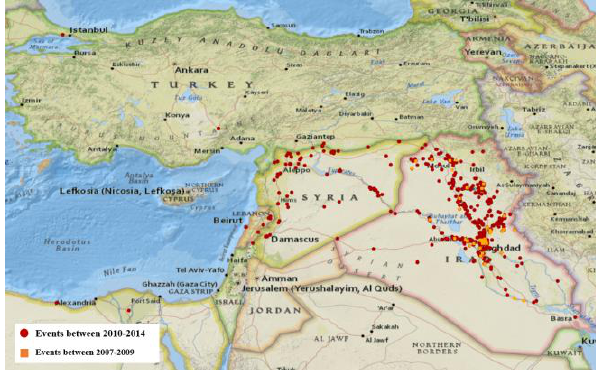
Figure 11 Event targets in different months